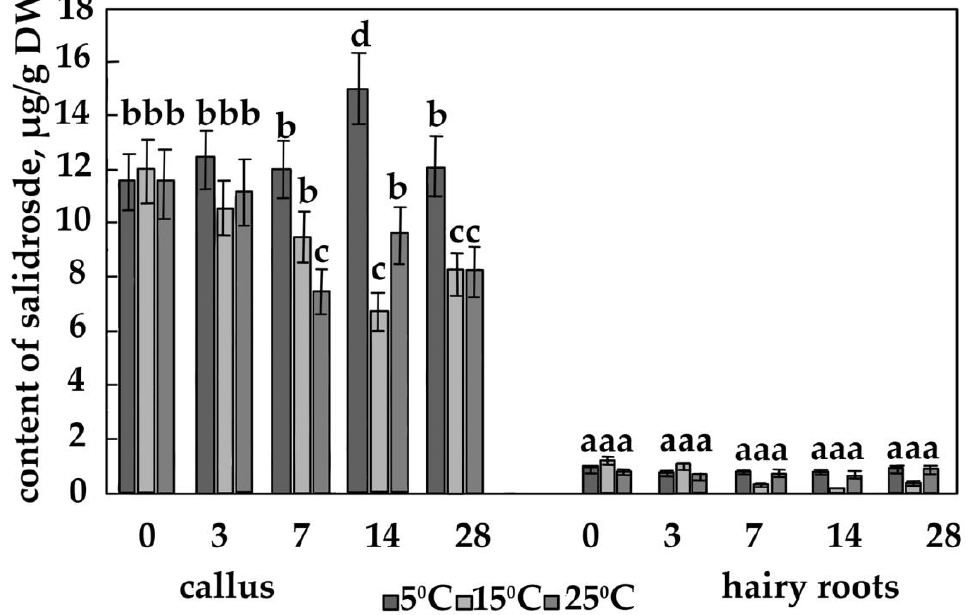
Figure 3. Salidroside content in calli and hairy roots of Rhodiola quadrifida. Cultivation at 5°C stimulated the formation of rosavin in calli significantly and it almost did not decrease during the cultivation cycle. On the third day of the experiment, the rosavin content in calli growing at 15°C increased sharply and did not differ signifi- cantly from the variant of cultivation at 5°C. Afterwards, however, it decreased rapidly and on day 7 was only 10.5% of the value at 5°C. Rosavin content, in general, was sig- nificantly lower at 25°C than at other temperatures (Figure 4). By the end of the cultiva- tion cycle, the content of rosavin at 15 and 25°C was 11.1 and 17.5% of its concentration in calli grown at 5°C. Only a residual amount of rosavin was noted in the roots throughout the cultivation cycle, regardless of temperature.